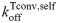
Multicellular model of T cell response.(a) A schematic illustration of the model. Each APC presents a self or non-self antigen. T cells are associated with APC in a stochastic manner, while the dissociation rate koff depends on the combination of antigen and TCR expressed on the T cell. These T cells divide only when they are associated with APC, which is suppressed by Treg cells in the environment. Tconv and Treg cells are supplied from outside the system constantly, in a ratio of 9:1, which is based on experimental observation [10]. Simultaneously, T cells which are not attached to APCs are discarded in a constant rate. (b) The distribution of koff for Tconv cells. Two distributions of koffTconv,self and koffTconv,non-self of Tconv cells supplied to the system are plotted. The parameters are μTconv,self = −3, μTconv,non−self = −3.75 (i.e., ΔTconv = 0.75), and σ = 1. (c) The distribution of koff for Treg cells supplied to the system. The parameters are μTreg,self = −3.75, μTconv,non−self = −3 (i.e., ΔTreg = 0.75), and σ = 1.